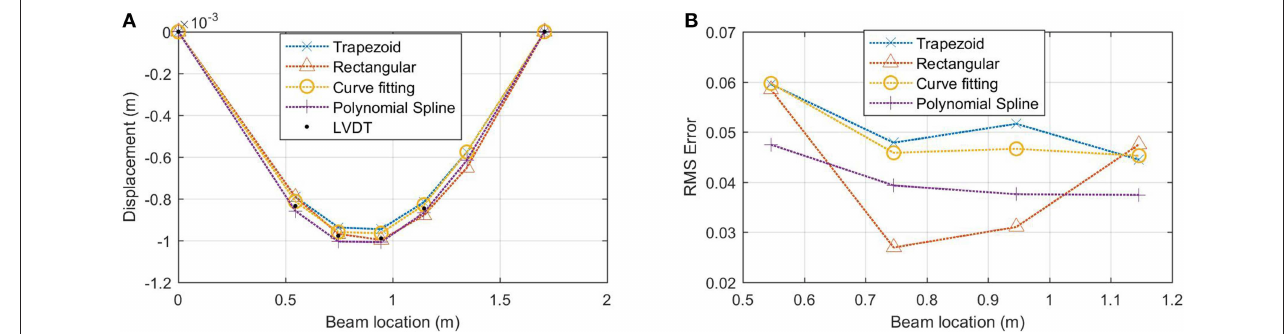
FIGURE 8 | Experimental free vibration results: (A) displacement at mid-span of simply supported beam, (B) RMS error, and (C) Pearson coefficient.